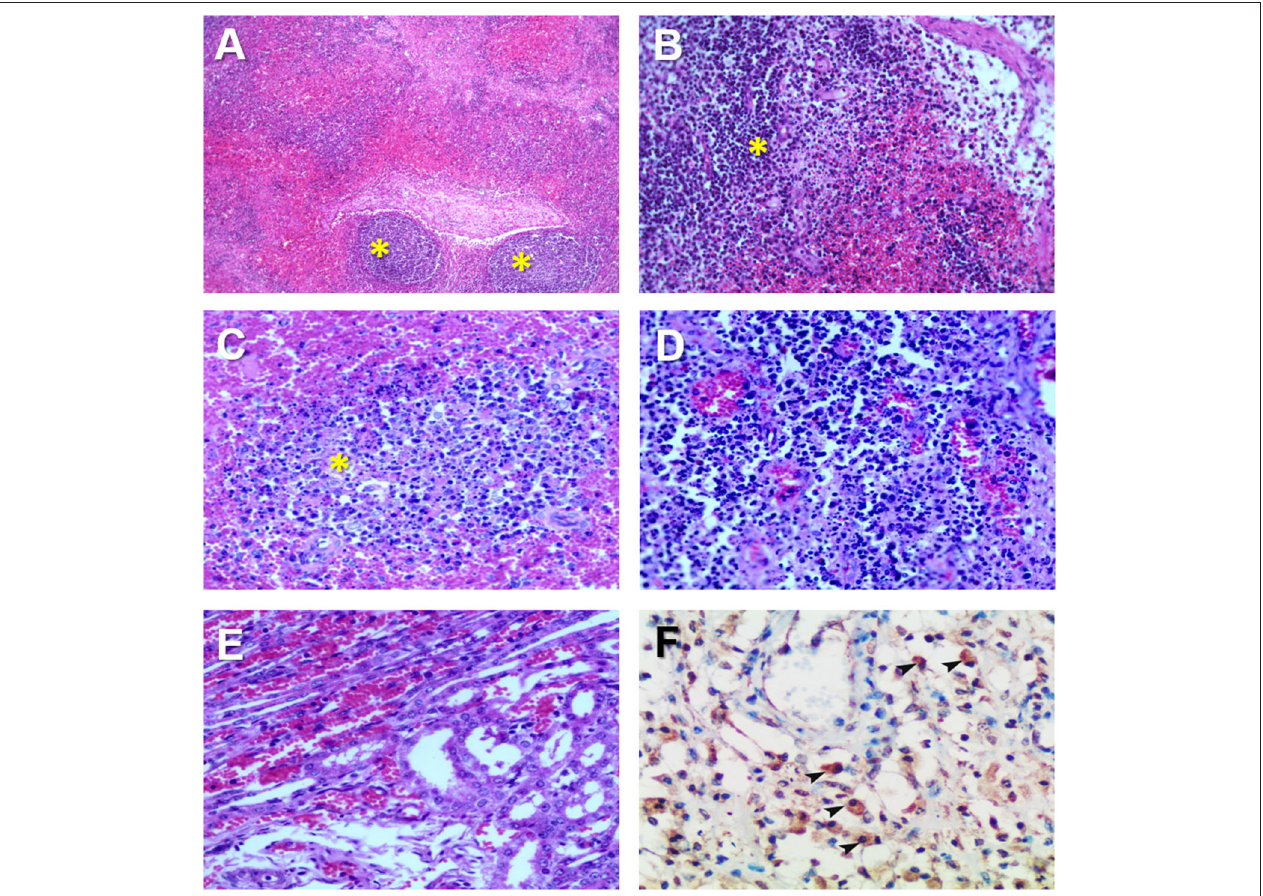
FIGURE 2 | Histopathological changes in ASFV infected pigs in Vietnam, 2019. (A) Lymph node: Severe hemorrhages within the lymph node medulla and lymphoid depletion in the follicles (*). H&E stain, 10X. (B) Lymph node: Severe hemorrhages within the lymph node medulla and lymphoid depletion in the follicles and parafollicular lymphoid tissue (*). H&E stain, 20X. (C) Spleen: Marked lymphoid depletion with the presence of pyknosis, karyorrhexis, and nuclear chromatin condensation within the splenic follicles (*) of the white pulp. H&E stain, 40X. (D) Tonsil: Lymphoid depletion, hyperaemia, and hemorrhages in the tonsil. (E) Kidney: Marked diffuse hemorrhaging within the renal cortex characterized by numerous extravasated red blood cells among renal tubuli. H&E stain, 40X. (F) Spleen: Immunohistochemical detection of ASFV p72 in abundant macrophages within the splenic red pulp (arrowheads). IHC stain (ABC technique),